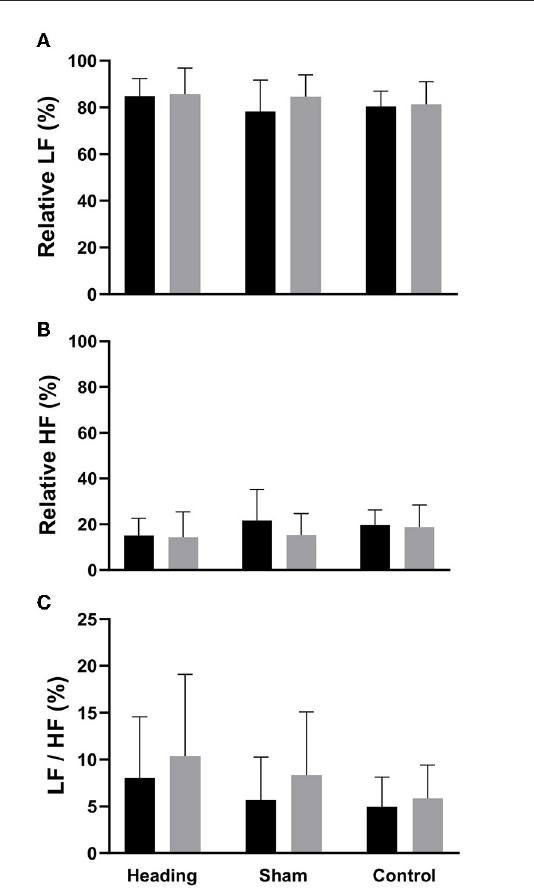
FIGURE4 Frequency-domain HRV metrics comparing before and after exposure to heading, sham, and control conditions across all participants. (A) relative lower frequency (LF) power. (B) relative high frequency (HF) power, and (C) LF/HF ratio. The columns are average values for the group with the standard deviation being represented with the error bars ( p- values all >